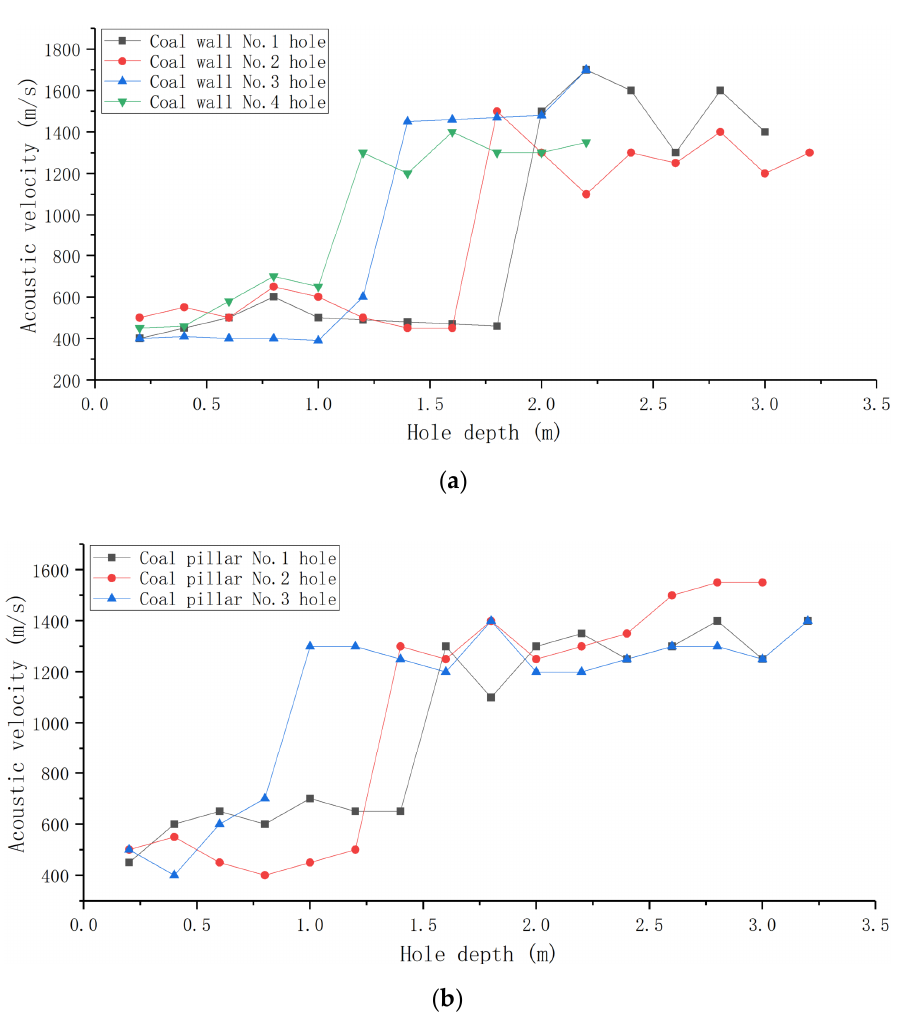
Figure 9. Acoustic propagation velocity of surrounding rock: ( a ) coal wall side hole; ( b ) coal pillar side hole.